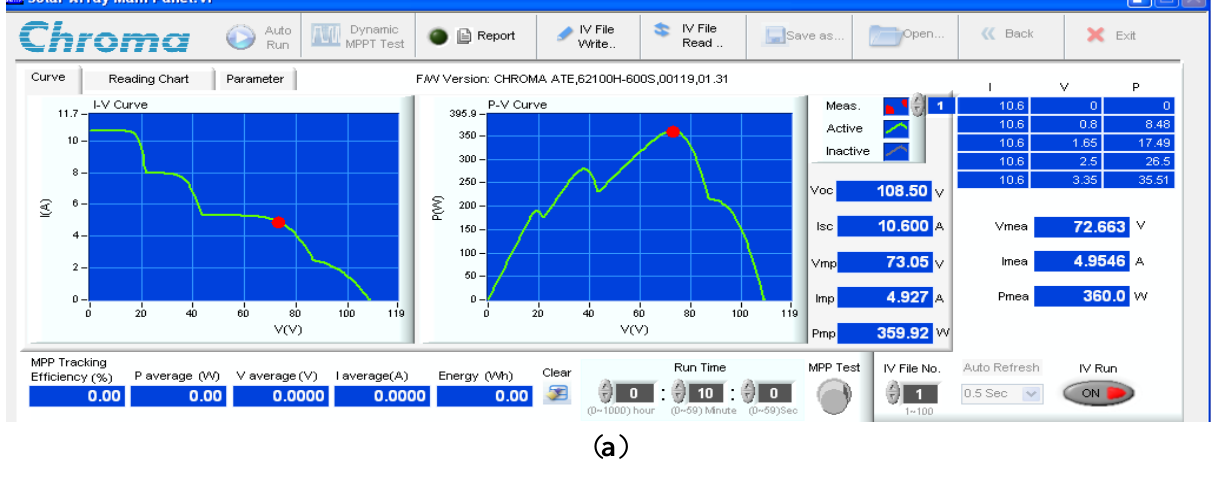
Figure 15. Experimental setup for proposed PV system.